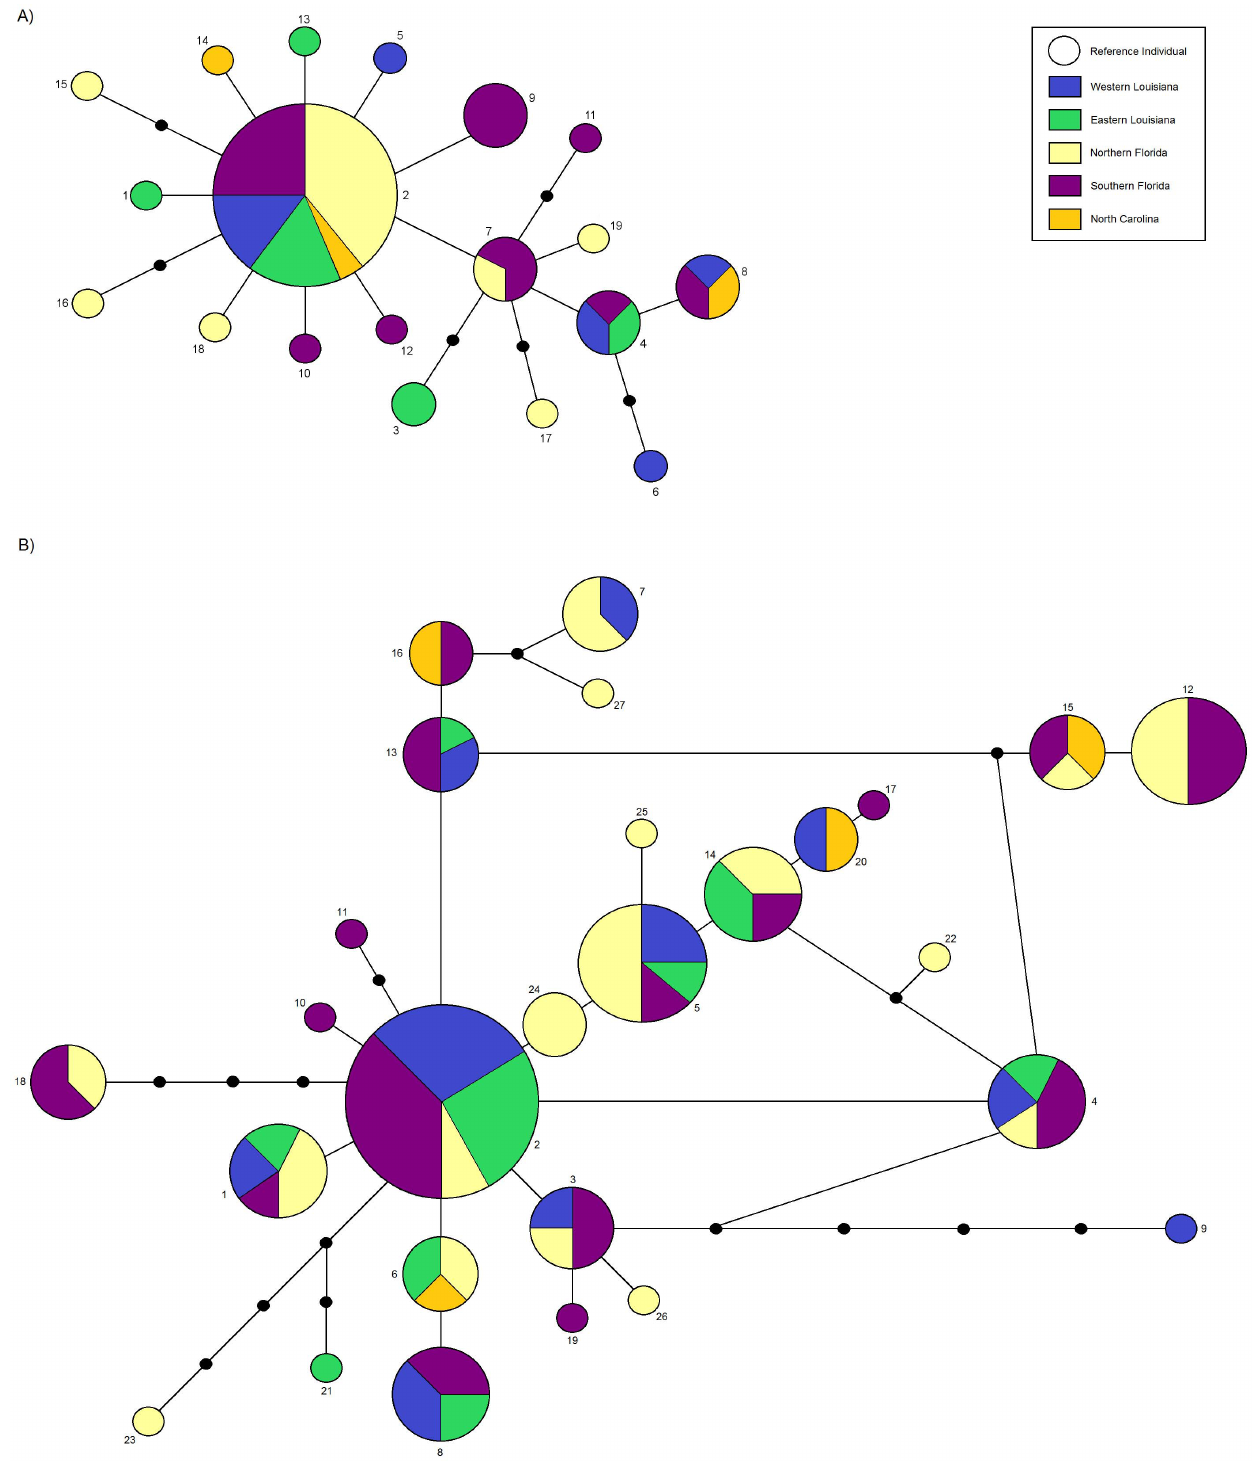
Figure 3. Unrooted parsimony haplotype networks for five regional populations of Bachman’s Sparrow. A) mitochondrial ND2 sequence data, and; B) nuclear TGF b 2 sequence data. Areas of circles are proportional to the number of individuals with that haplotype and haplotype number is listed next to circles. A haplotype found in a single individual is given as a size reference in the legend. Small black circles indicate a missing haplotype (one that either was not recovered during sampling or is extinct).